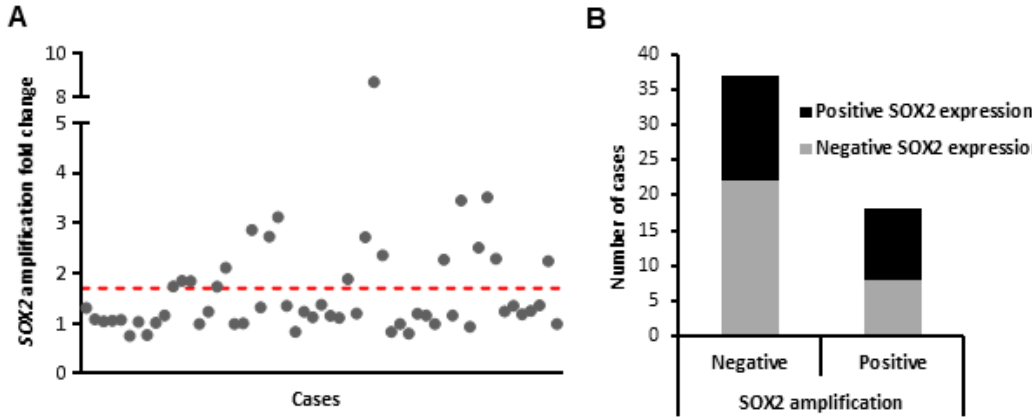
Figure 2. Analysis of SOX2 gene amplification in laryngeal precancerous lesions. SOX2 gene copy number was evaluated by Q-PCR in 55 cases. ( A ) Data are represented as fold-change in the precancerous lesion relative to the normal mucosa. Red dotted line indicates the threshold established to define positive cases (1.75). ( B ) Correlations between SOX2 gene amplification and protein expression determined by immunohistochemistry.